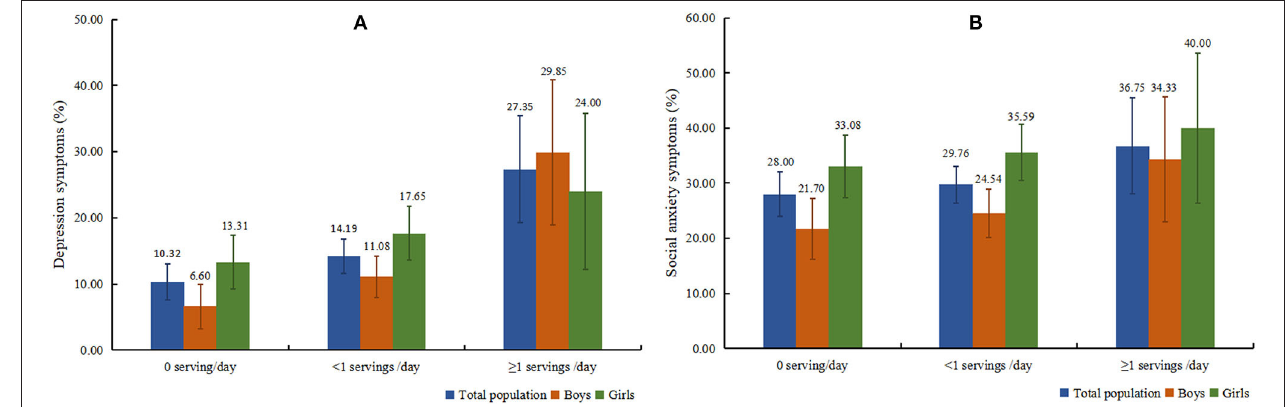
FIGURE 1 | Prevalence of depressive (A) and social anxiety (B) symptoms among total population and boys and girls, respectively.